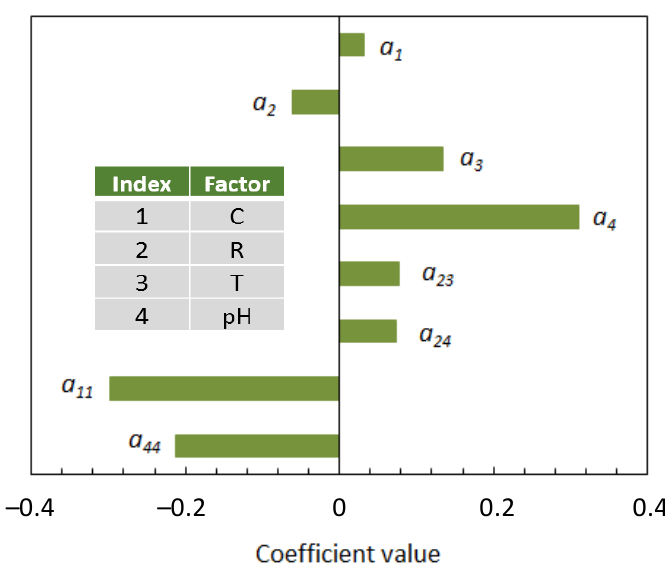
Figure 4. Pareto chart for the model coefficients.